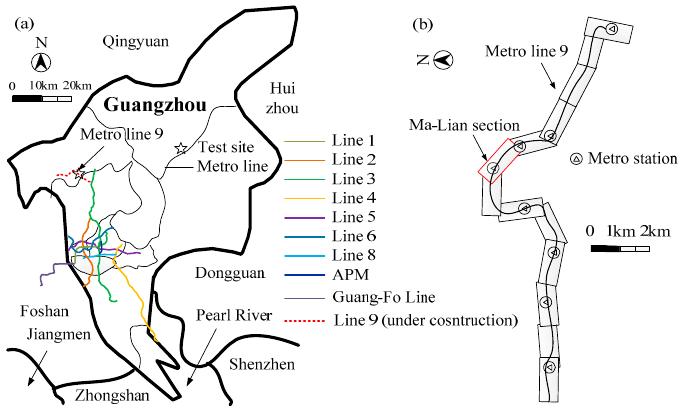
Figure 6. Background description for the presented case study ( a ); Map of metro system of Guangzhou and location of the worksite ( b ).